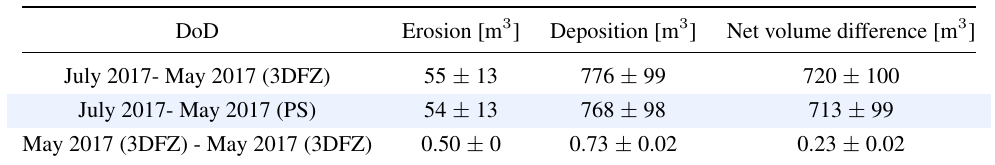
Table 1. Total volume of erosion and deposition and net volume change for the computed